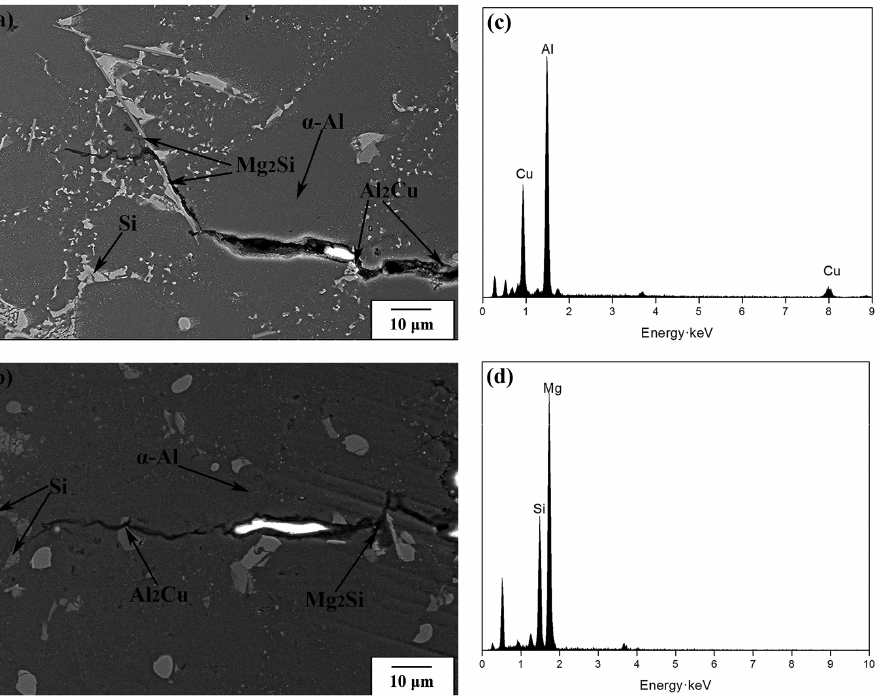
Figure 10: SEM micrographs and EDS analyses of crack initiation and propagation behavior around the secondary phase in Al-Si-Cu-Mg alloy